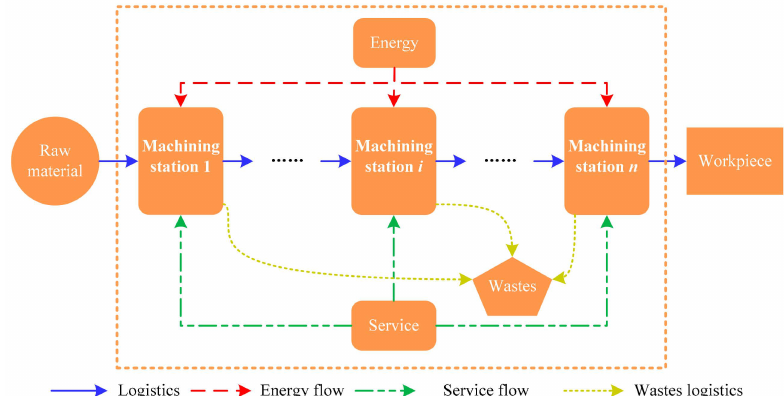
Figure 1. Boundary of sustainable machining